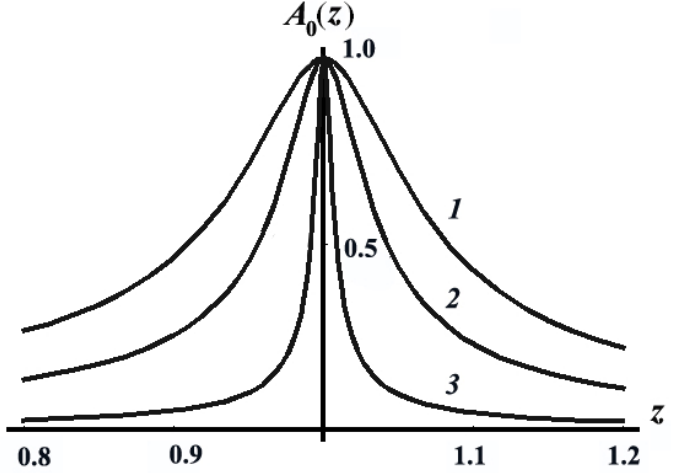
Figure 2. Dependence of the dimensionless vibration amplitude of the droplet surface A 0 ( z ) = δ R m / δ R max on the pump frequency ω divided by the natural frequency Ω (where z = ω / Ω ) for some values of the dimensional less amplitude P a of acoustic pressure: 1 − P a = 0.1; 2 − P a = 0.05; 3 − P a = 0.01.